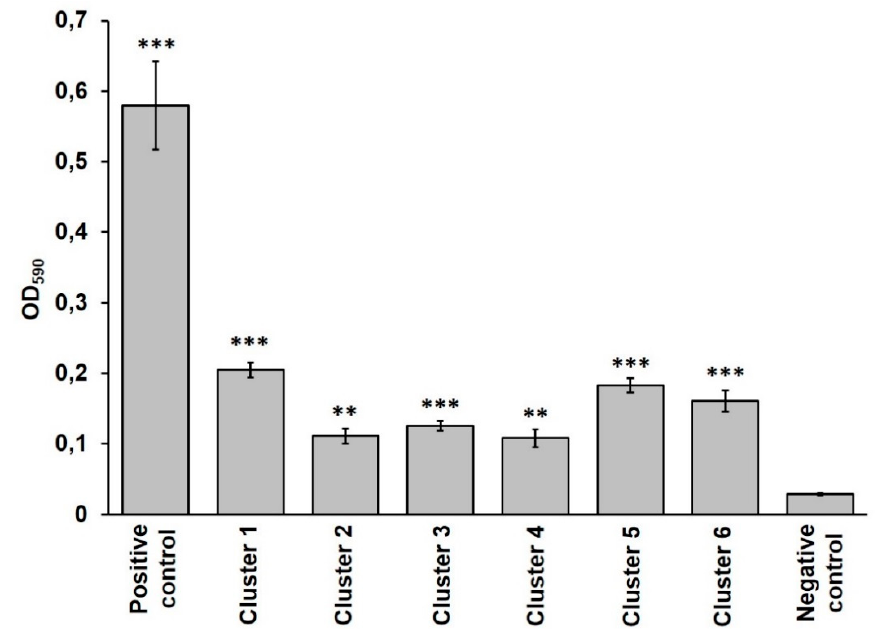
Figure 3. Biofilm formation by each B. cereus cluster evaluated by the crystal violet assay (OD 590 ). Positive control: B. cereus ATCC 10987; negative control: sterile LB. Data are expressed as mean ± S.D. ** p < 0.01, and *** p < 0.001 compared to the negative control.4 Discussion.